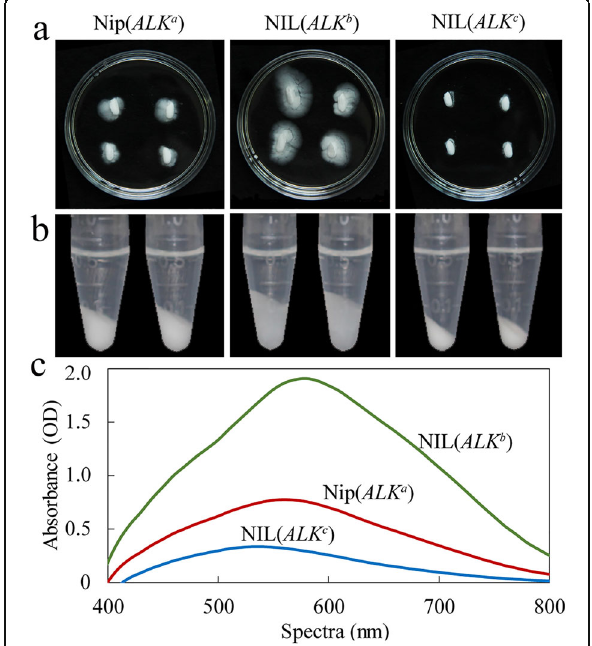
Fig. 2 Gelatinization properties of rice grains or flours from three near-isogenic lines (NILs) with different ALK alleles. a Alkali spreading test of milled rice in 1.4% potassium hydroxide (KOH) solution. b Gelatinization of rice flour in 4.0 mol/L urea solution. c I 2 -KI absorption spectroscopic analysis of the gelatinized supernatant fractions from rice flours in urea solution as shown in panel